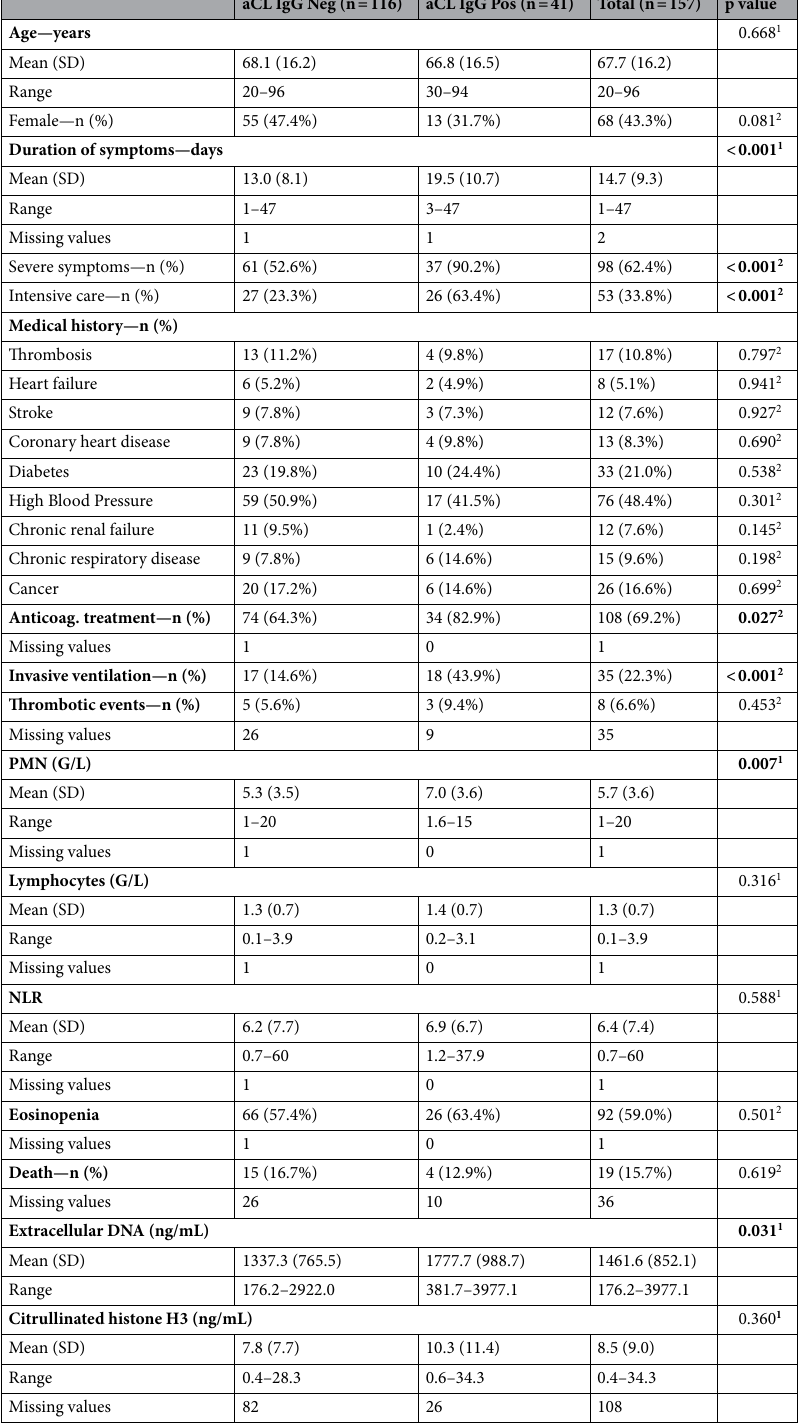
Table 4. Anti-cardiolipin autoantibodies in patients with COVID-19. PMN polymorphonuclear neutrophils, NLR neutrophil–lymphocyte ratio, 1 Student’s t test, 2 Pearson’s Chi-squared